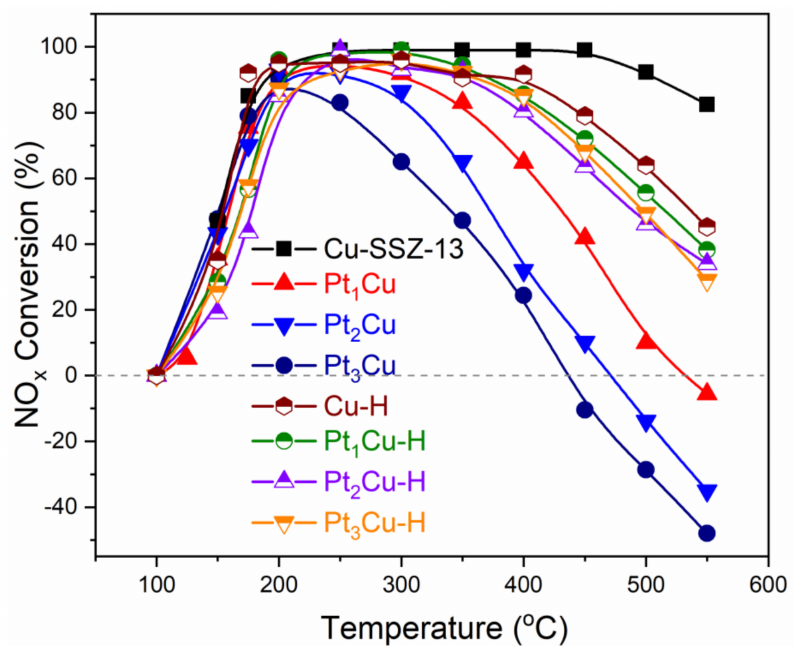
Figure 1. NO x conversion during standard NH 3 − SCR with the fresh and aged samples. The reaction conditions: 500 ppm NH 3 , 500 ppm NO, 5% O 2 , 5% H 2 O, N 2 balance, flow rate at 500 mL/min, 100 mg of catalyst.